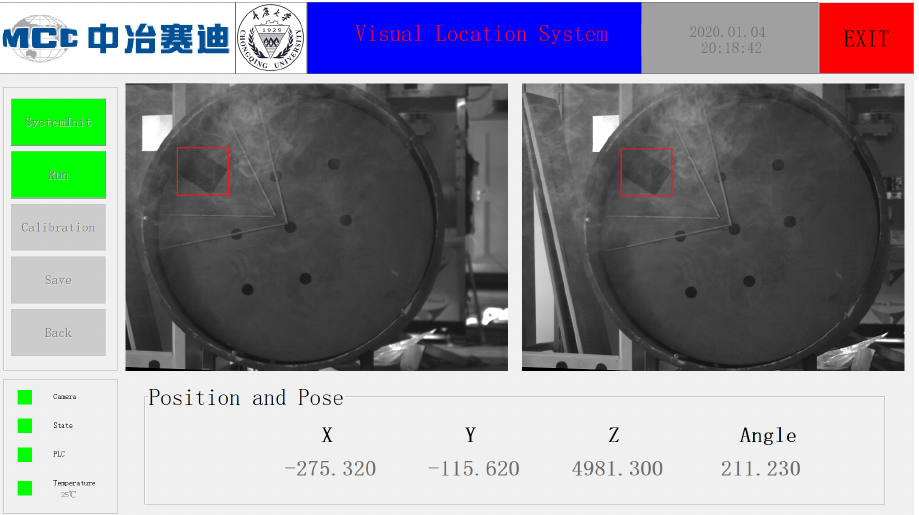
Figure 19. Interface of